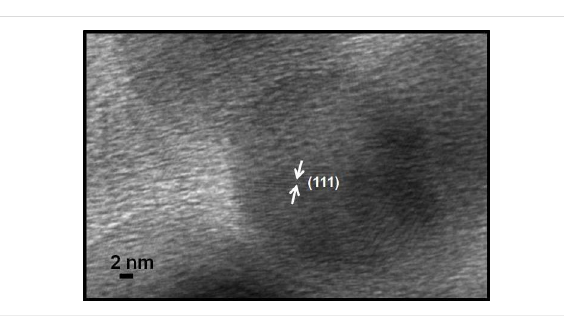
Figure 5: High-resolution TEM micrograph of Pt(1%)-ZrO 2 .